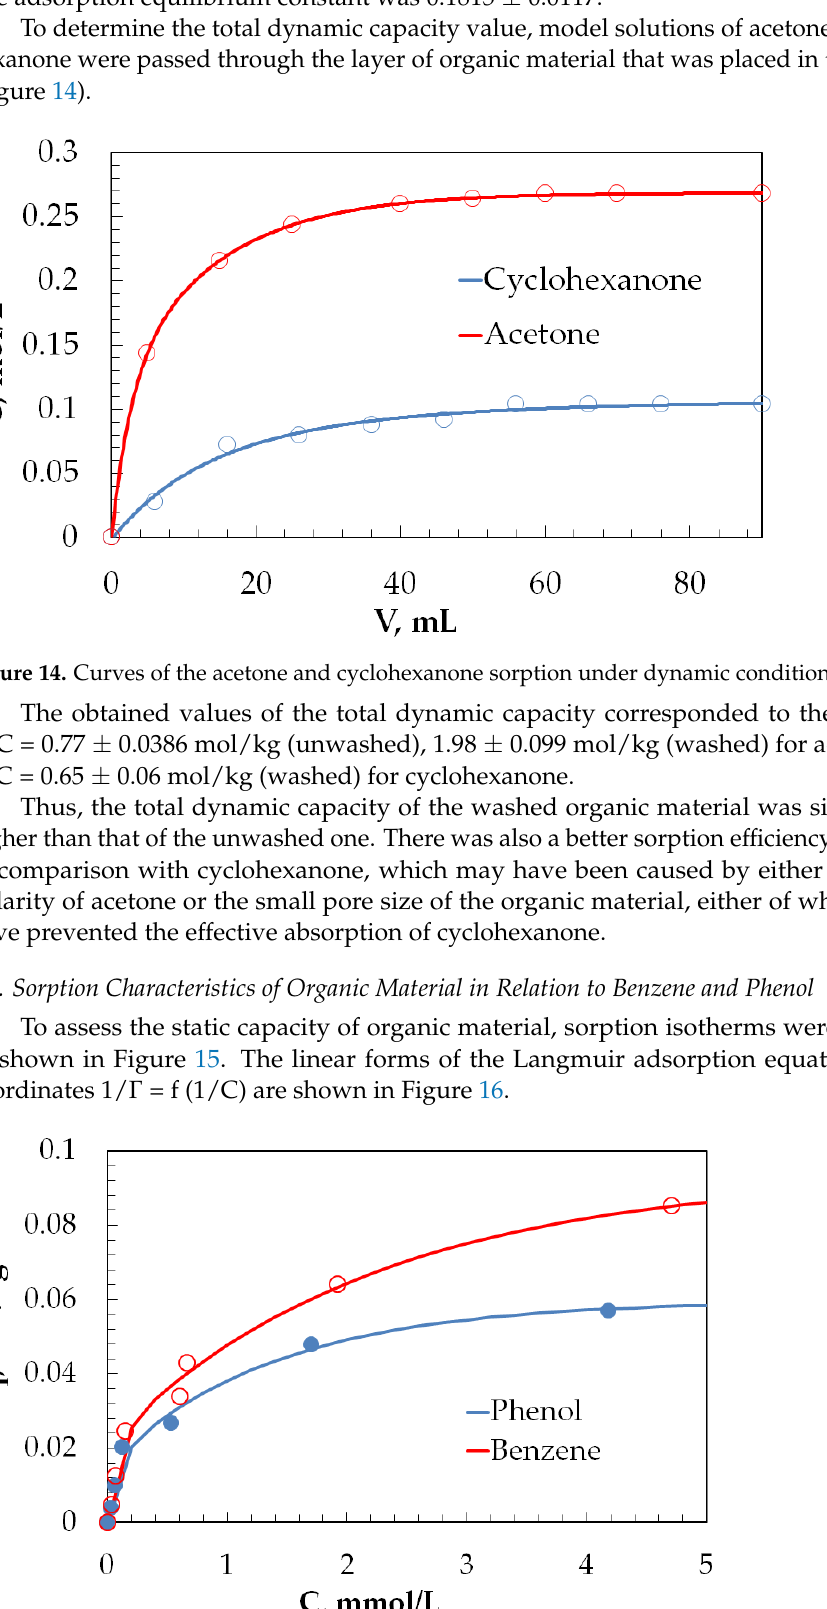
Figure 13. Linear form of the sorption isotherm of acetone on organic material.